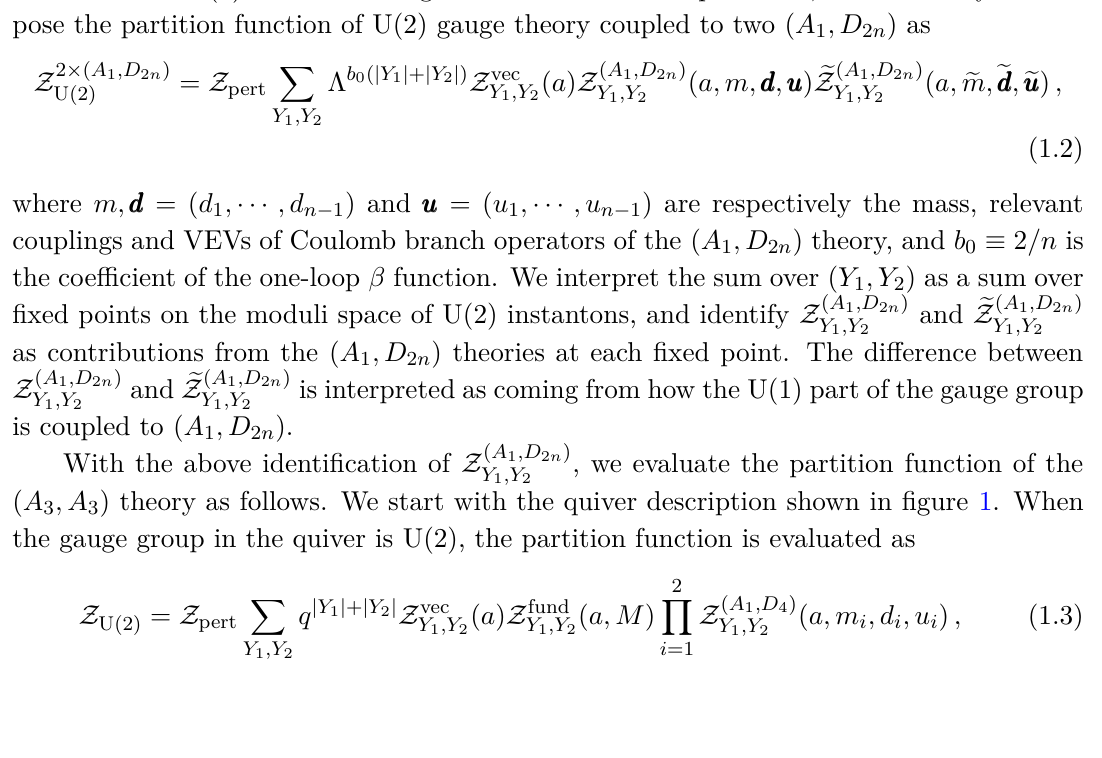
Figure 2 . A typical example of gauge theories studied in the generalized AGT correspondence, where n is a positive integer. The circle stands for SU(2) gauge group, and each box stands for an ( A ) theory. The SU(2) vector multiplet is diagonally gauging an SU(2) sub-group of the 1 , D 2 n ( A ) 1 , D 2 n